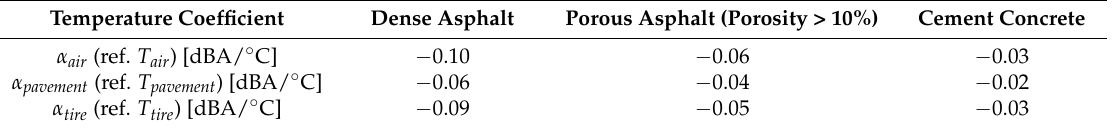
Table 14. Temperature coefficients of the relationship between pass-by noise level at 90 km/h and air, pavement or tire temperatures, per road pavement category (source from Anfosso-L é d é E and Pichaud, 2007 [311], Table 5; reprinted with permission from